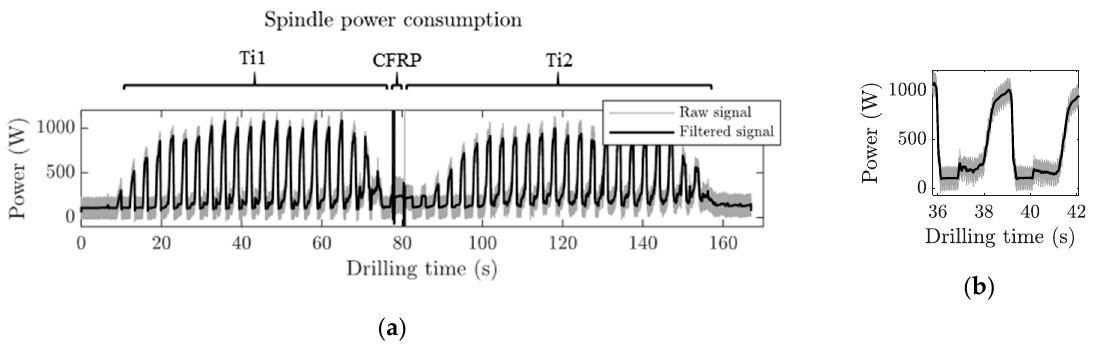
Figure 11. Spindle power consumption signal of hole 40 with the higher lubrication level (15 mL/h) recorded during Ti/CFRP/Ti stack drilling. ( a ) The complete signal of the drilling process. ( b ) A detailed view of a peck drilling cycle on the first Ti layer.